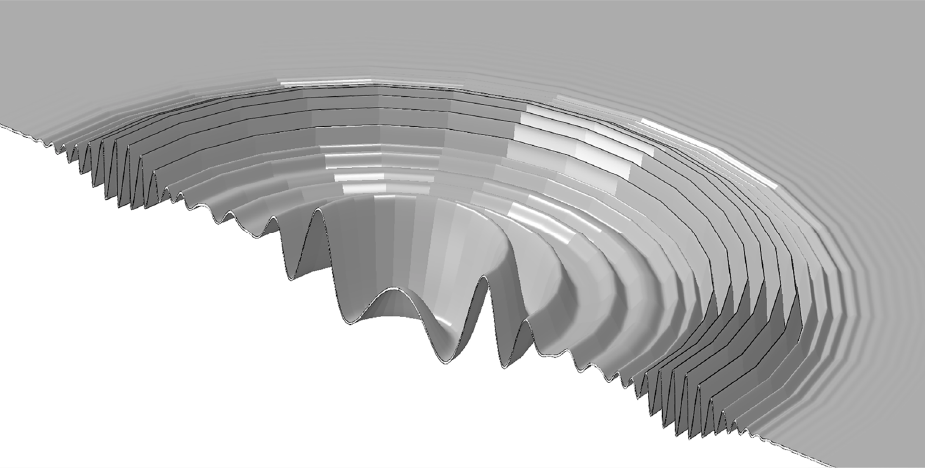
Figure 6. Example of tone burst displacements as a result of the axis-symmetric model.